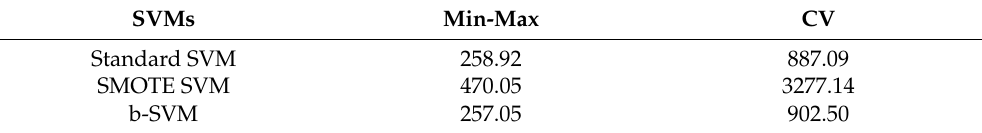
Table 4. Completion time (s) of SVMs using different gamma selections in simulated high